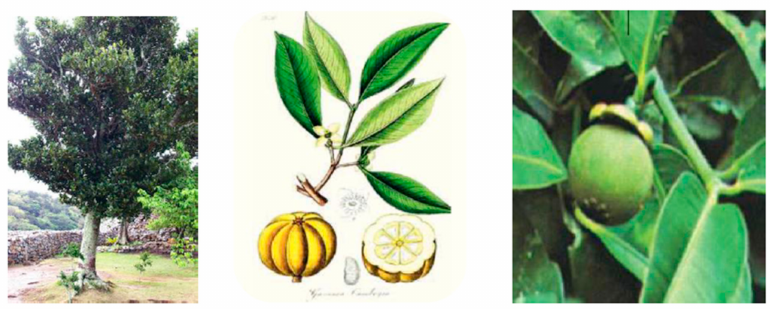
Figure 2. Tree, branch, and fruit of Garcinia cambogia .